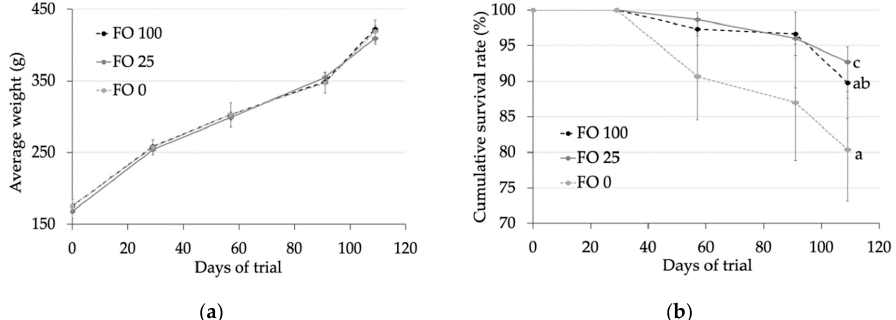
Figure 1. ( a ) Fish live weight (g) and ( b ) survival (%) of fish fed experimental diets during the 109 days of trial. Values are expressed as means ± standard error. Table 3. Fat content and fatty acid composition (% of total fatty acid content) of the brain in Mediterranean yellowtail fed the experimental diets ( n = 12 per diet). Values are expressed as least square (LS)means. Diet p